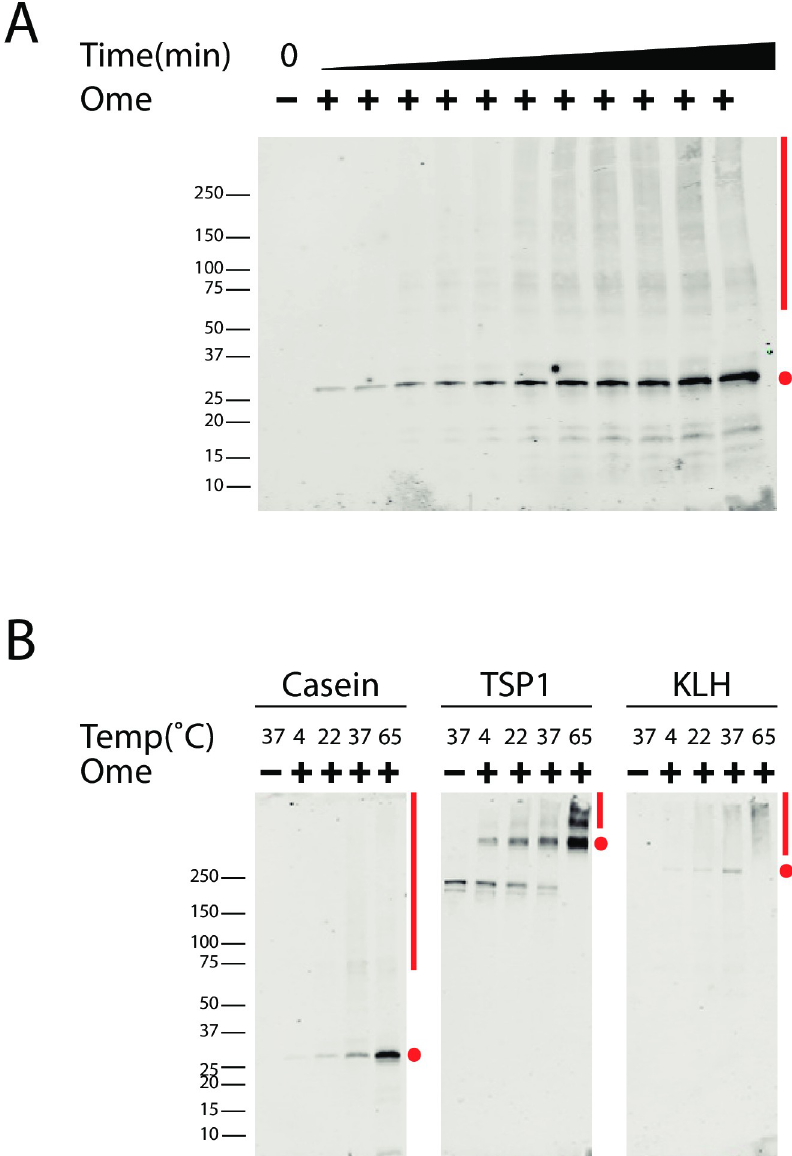
Fig 5. Time and temperature dependent omeprazole-protein complex formation. (A) Incubation of 1mM omeprazole with non-cysteine containing protein, casein, at 65˚C indicates a time dependent (0.5, 1, 5, 10, 15, 30, 45, 60, 75, 90, and 120 minute points) increase in omeprazole-casein complex which was recognized by the antibody. (B) Omeprazole (1mM) reaction with purified proteins, casein, TSP1, KLH, for 2hr at 4, 22, 37, and 65˚C show that there is increased complex formation with increased temperature. Note that the lowest molecular weight TSP1 band reacted with the antibody without omeprazole, representing a non-specific reaction; higher molecular weight bands are specific for omeprazole treatment. There is higher molecular weight oligomer formation with both the time and temperature dependent studies; baseline state (•) and omeprazole-dependent higher molecular weight states ( ׀ ) are marked. Oligomerization was especially pronounced in TSP1. There was no reducing agent in sample loading buffer, and samples were not boiled. Protein molecular masses are as follows: for casein (monomer at 27kD), TSP1 (baseline multimer > 250kD), and KLH (monomer at > 250kD). 5C3 antibody (1:50 dilution) was used for the detection of the